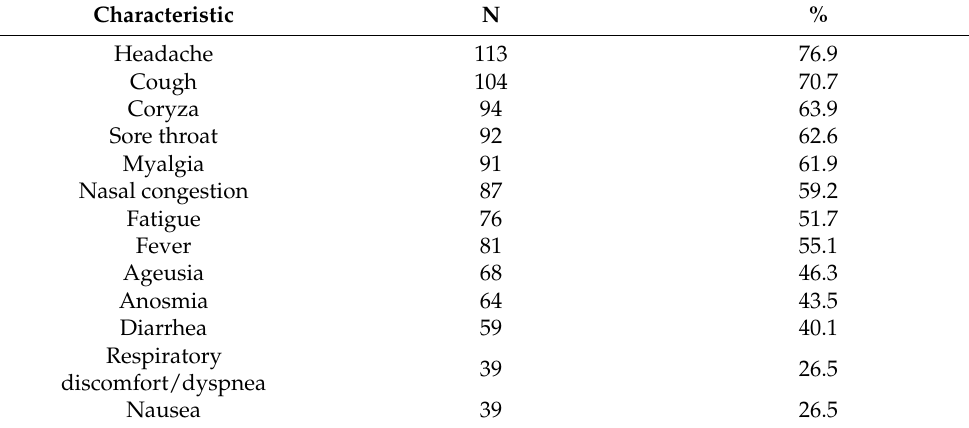
Table 2. Self-reported initial symptoms of coronavirus disease 2019 (COVID-19).